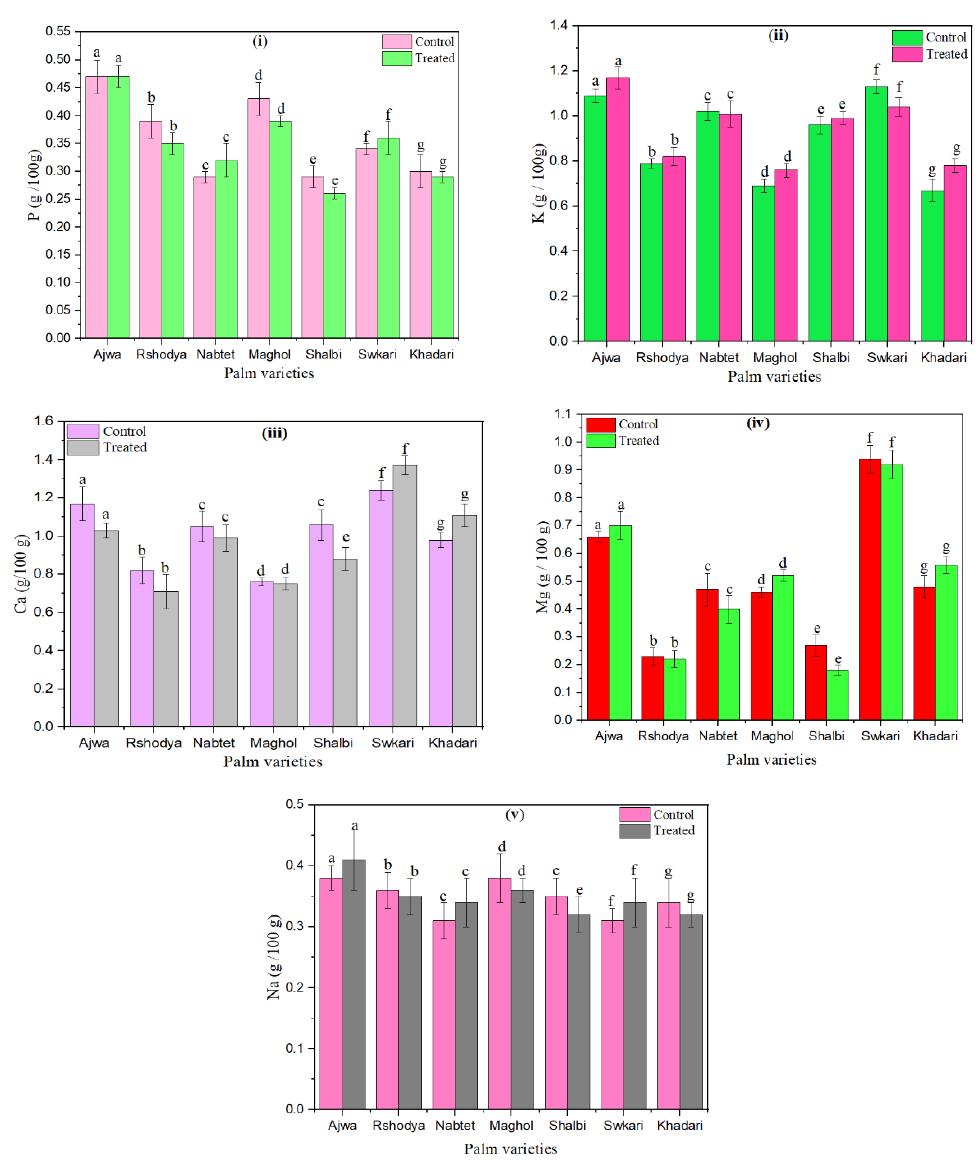
Figure 4. The effect of SDBD plasma on macro elements (g/100 g) of palm dates, ( i ) P, p value = 0.99, ( ii ) K, p value = 0.06, ( iii ) Ca, p value = 0.4i, ( iv ) Mg, p value = 0.05, and ( v ) Na, p value = 0.35, lowercase letters a–g in the same column represent significance analysis; the different letters mean significant difference among various treatments at p < 0.05 level